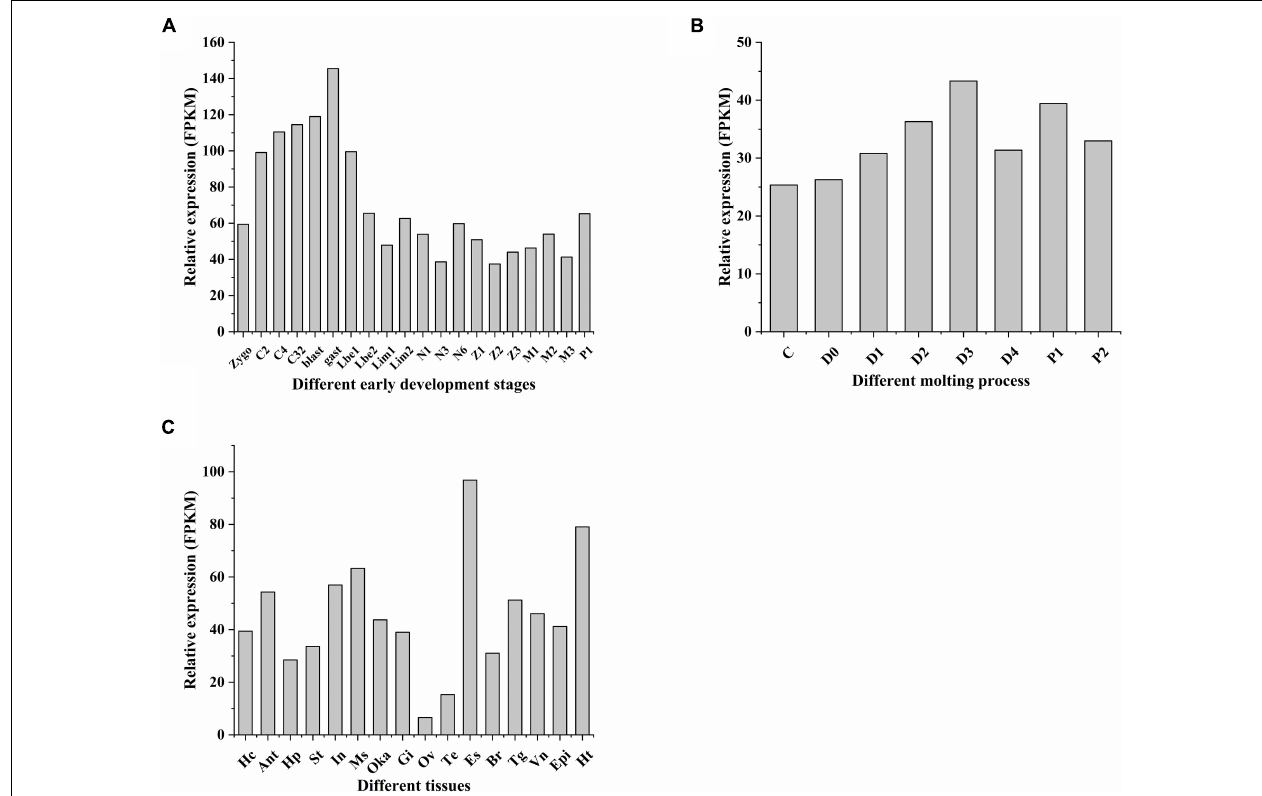
FIGURE 5 | The expression profiles of LvGSK3 gene. (A) Early development stages: zygote (zygo), 2 cells (C2), 4 cells (C4), 32 cells (C32), blastula (blast), gastrula (gast), limb bud embryo I (Lbe1), limb bud embryo II (Lbe2), larva in membrane I (Lim1), larva in membrane II (Lim2), nauplius I (N1), nauplius III (N3), nauplius VI (N6),